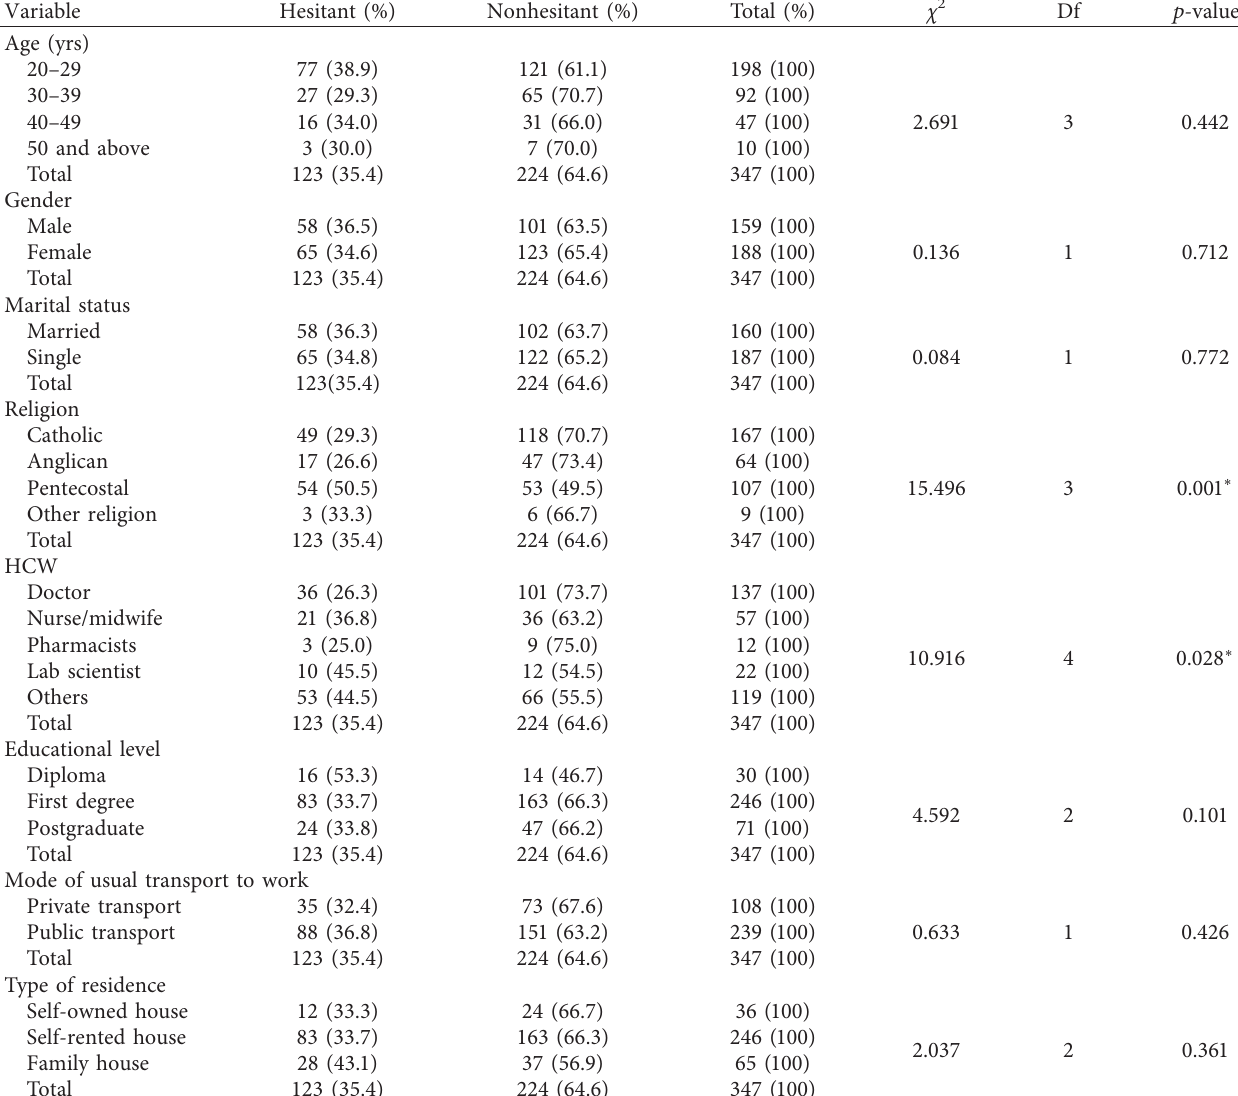
Table 1: Sociodemographic characteristics and vaccine hesitancy among HCWs in Imo State,